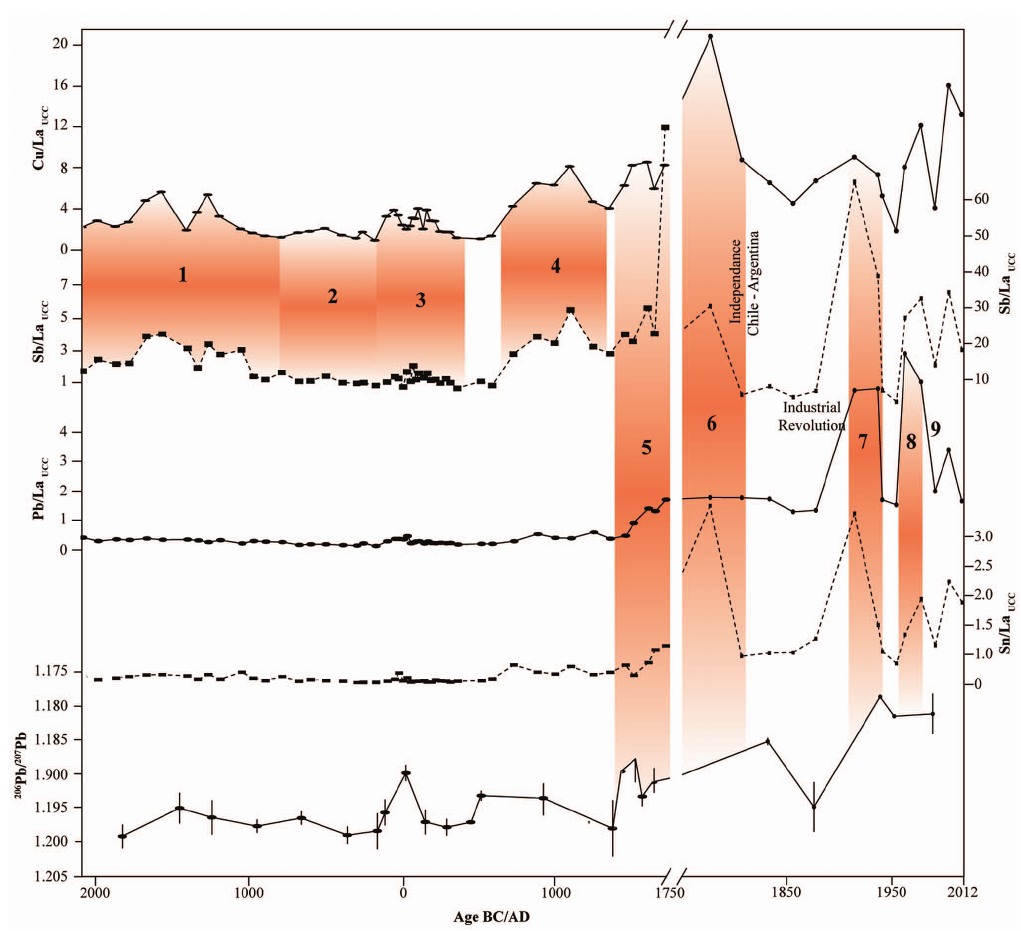
Figure 6. UCC-normalized Cu, Sb, Pb and Sn vs. La ratios [37] and 206 Pb/ 207 Pb isotopic ratios in the Karukinka peat core during the last 4200 yrs (ombrotrophic part of the core). Maximum likelihood ages are expressed in years Anno Domini (AD) and Before Christ (BC). The age scale is cut at 1750 AD and the Sb/La UCC scale changes at 1750AD. 1. Onset of Cu metallurgy, 2. Chavin, 3. Nazca and Ramaditas, 4. Tiwanaku, 5. Inca (transition from Cu to Ag mining), 6. European Colonization, 7. Gold rush and bronze industry, 8. Leaded gasoline period, 9. Unleaded gasoline period (see text for details).